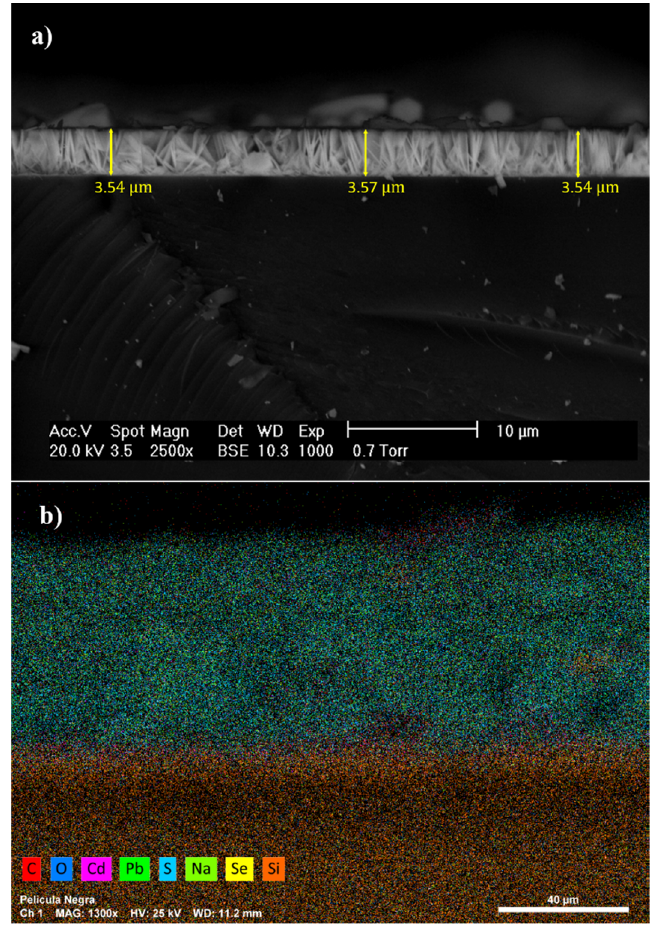
Figure 4. ( a ) SEM micrograph showing the cross-sectional view of the CdS/Pb 5 (CO 3 ) 3 O(OH) 2 heterojunction to estimate its thickness, and ( b ) perspective view of EDS elementary mapping of the CdS/PbSe heterojunction to analyze its elemental composition and their distribution.